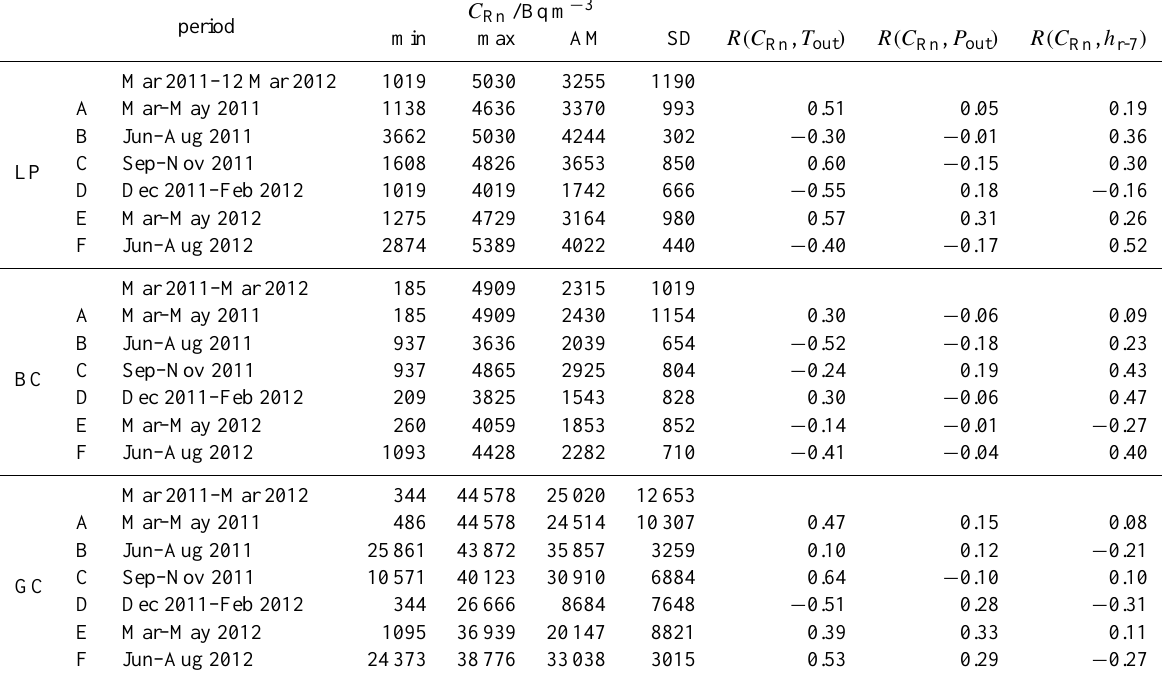
Table 2. Basic statistics (min – minimum, max – maximum, AM – arithmetic mean and SD – standard deviation) of radon concentration ( C Rn ) at locations LP, BC and GC in 6 periods (A to F) and correlation coefficient R between C Rn and outside air temperature ( T out ) , C Rn and atmospheric pressure ( P out ) , and C Rn and cumulative height of rainfall in the last 7 days ( h r-7 ) for each location and time